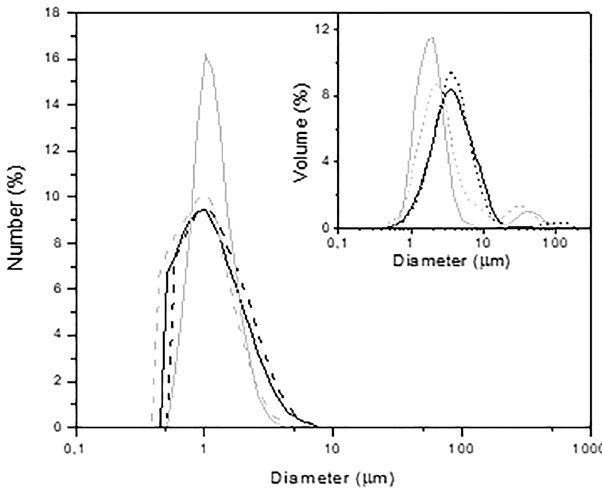
Figure 4. Number distribution of particles for dried (black) and calcined (gray) xerogel powders for the L (---) and SP (—) protocols. Inset correspond to the volume distribution of the particles.